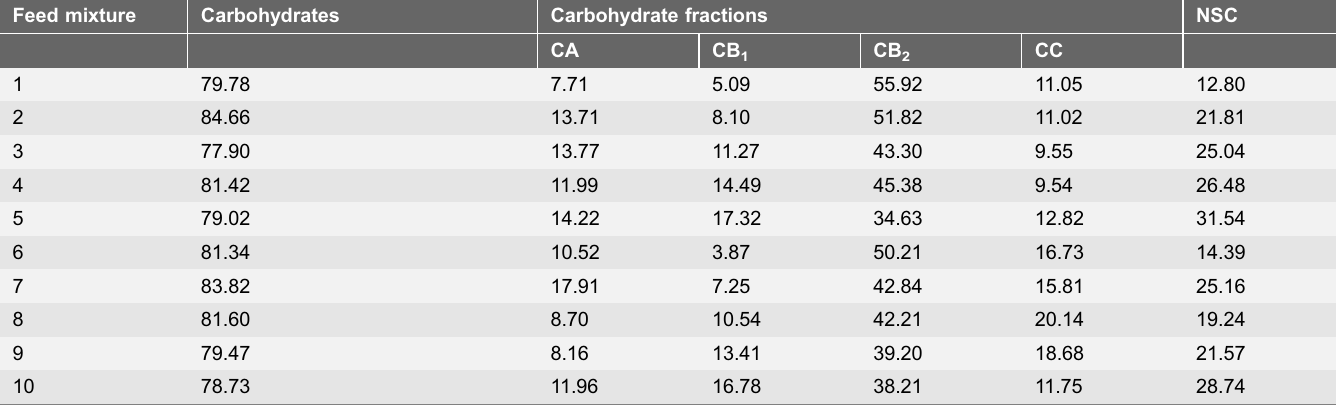
Table 4. The CNCPS carbohydrate fractions of feed mixtures for evaluating the model (%DM). Feed